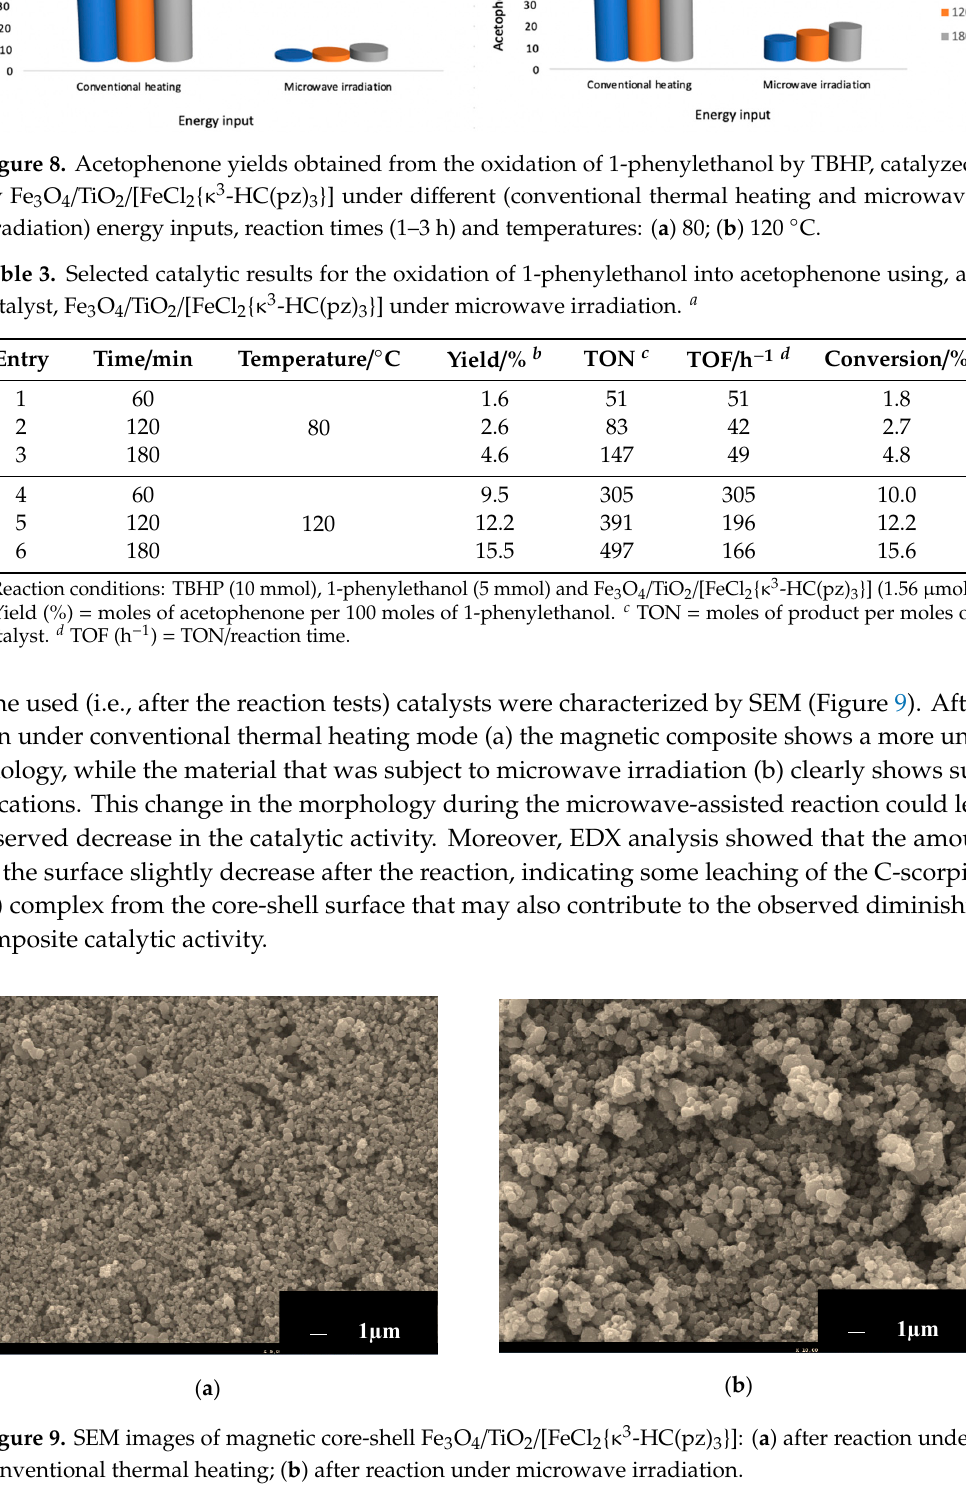
Figure 9. SEM images of magnetic core-shell Fe 3 O 4 / TiO 2 / [FeCl 2 { κ 3 -HC(pz) 3 }]: ( a ) after reaction under conventional thermal heating; ( b ) after reaction under microwave irradiation.